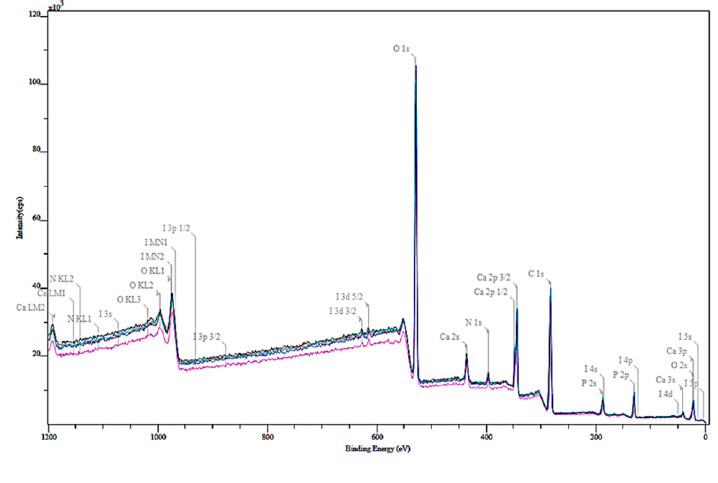
Figure 10. XPS spectrum of a sample 5CC. Table 5. Detailed data of XPS analysis for considered peaks—sample